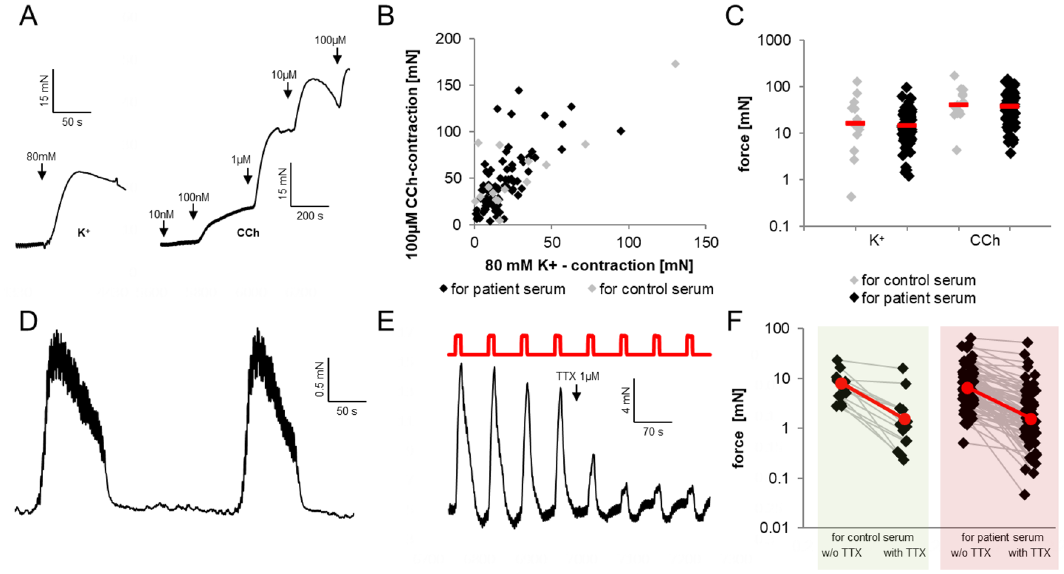
Figure 2. Representative traces of spontaneous mechanical activity and responses of human colonic smooth muscle strips to high-K + , CCh and electric field stimulation. ( A ) Contractile response to an increase in K + and cumulative CCh applications in the organ bath. Arrows depict the time point of substance application. ( B ) Correlation of responses to the highest CCh-concentration and high-K + within strips shown in grey for strips later on incubated with serum from healthy controls and in black for those later on incubated with patient’s sera. ( C ) Peak amplitudes of mechanical responses to high-K + and CCh, again separated according to the type of serum used for the subsequent incubation period. ( D ) Spontaneous rhythmic activity of a muscle strip exhibiting low-amplitude, high-frequency waves superimposed on low-frequency-high-amplitude contractions. The amplitude of ripples was measured using the “mean cyclic height”-function in LabChart over a representative 10-s period. Low-frequency waves occurred in 24, ripples in 65 of 98 muscle strips. ( E ) Rhythmic application of trains of electric field stimulations (red trace depicts timing of trains) induces regular contractions of colonic smooth muscle strips (black trace). Application of tetrodotoxin (TTX) leads to a marked reduction in the amplitude of responses. Note the spontaneous high-frequency, low-amplitude activity underlying the pattern of exogenously evoked contractions. ( F ) Effects of 1 µM TTX on EFS-triggered contractions prior to serum incubation in muscle strips for later incubation with control or patient serum, respectively. Red rhombs and bars depict median